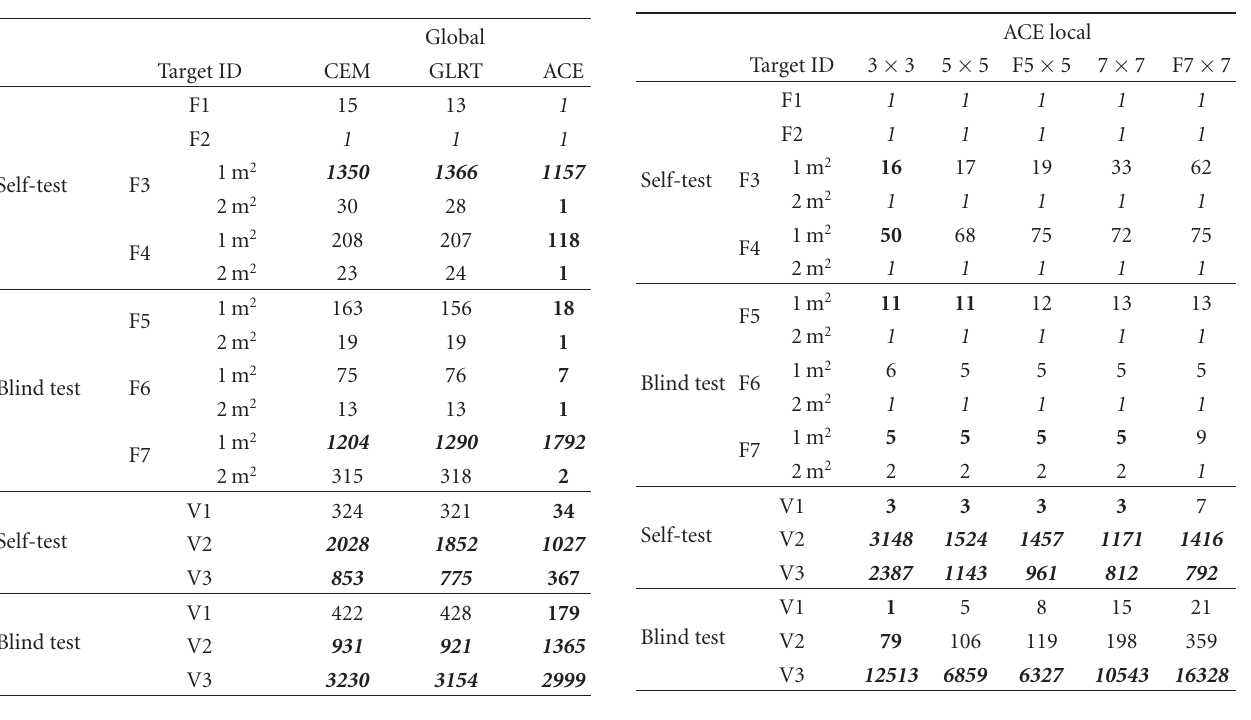
Table 5: Benchmark